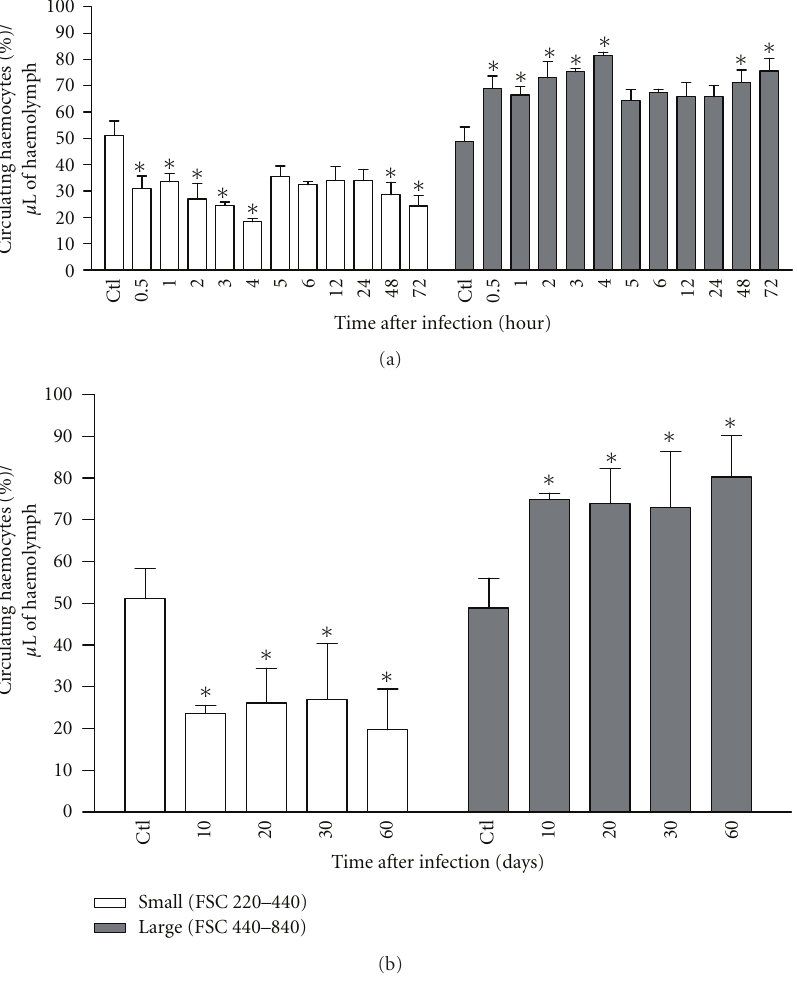
Figure 3: Percentual number of small (R1) and large (R2) haemocyte subpopulations in 1 µ m of haemolymph of Biomphalaria glabrata free from infection with Angiostrongylus vasorum (Ctl) and in 1 µ m of haemolymph of B. glabrata exposed to 1,000 first-stage larvae of A. vasorum at di ff erent times of infection. Data are presented as mean number ± standard deviation of circulating haemocyte subpopulations. ( ∗ ) Represents significant di ff erences ( P < 0 . 05) in the number of haemocytes at each point of infection for the control group.